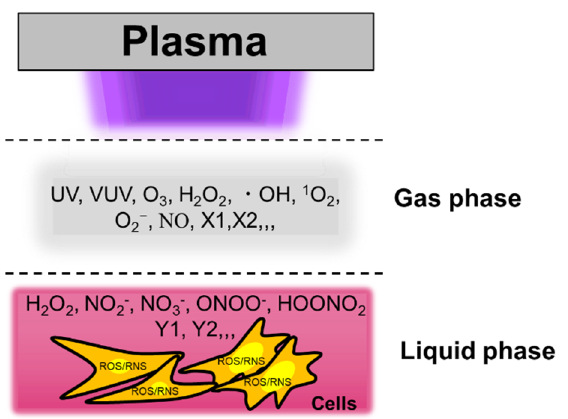
Figure 2. Reactive species in the plasma gas phase dissolve into the bulk liquid to subsequently reach the cells with potentially cytotoxic consequences. The example shows an in vitro setup. Modified from [29] . Copyright 2014 IEEE.